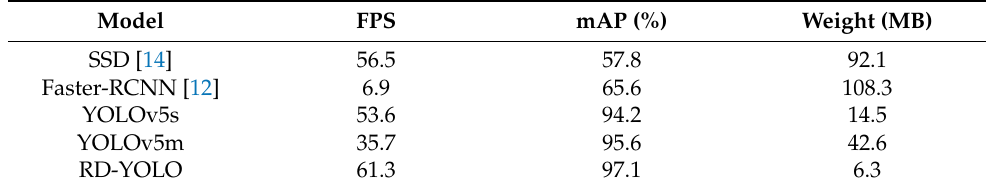
Table 6. Performance comparison of different algorithms on the UA-DETRAC